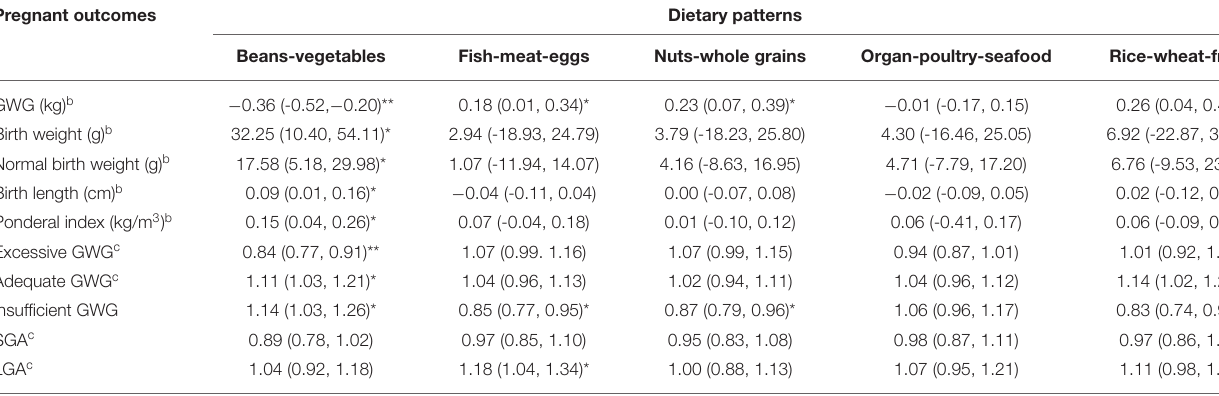
TABLE 3 | Associations between maternal dietary pattern scores and pregnant outcomes a . Pregnant outcomes Dietary patterns